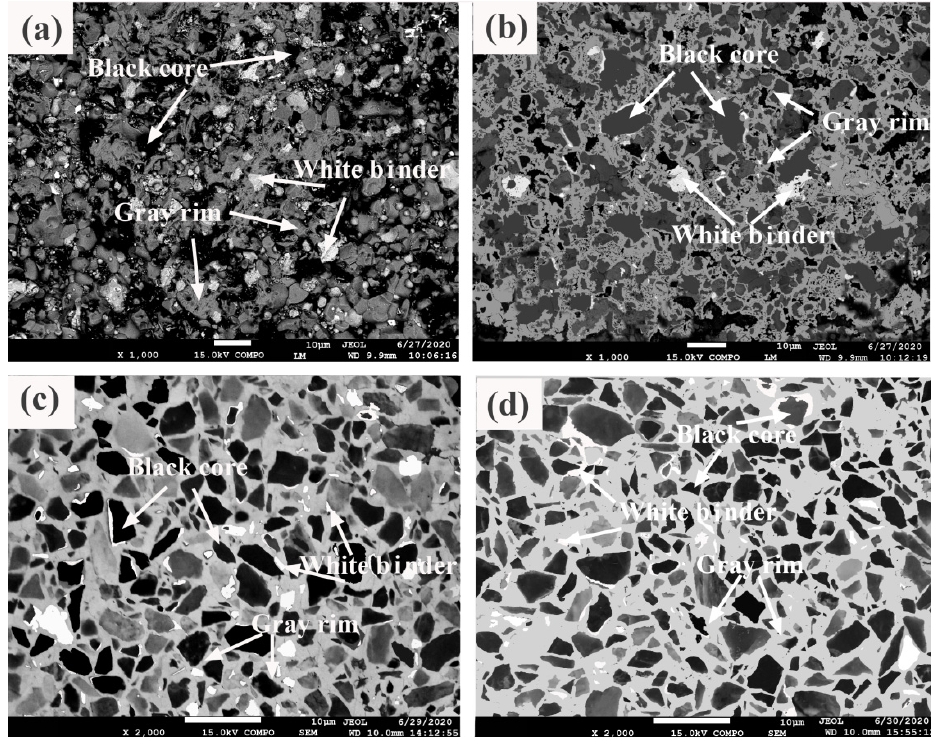
Figure 6. SEM–BSE micrographs for Ti(C,N)-based cermets: ( a ) 20Ni-1350 °C; ( b ) 20Ni-1400 °C; ( c ) 20Ni-1450 °C; ( d ) 20Ni-1500 °C.